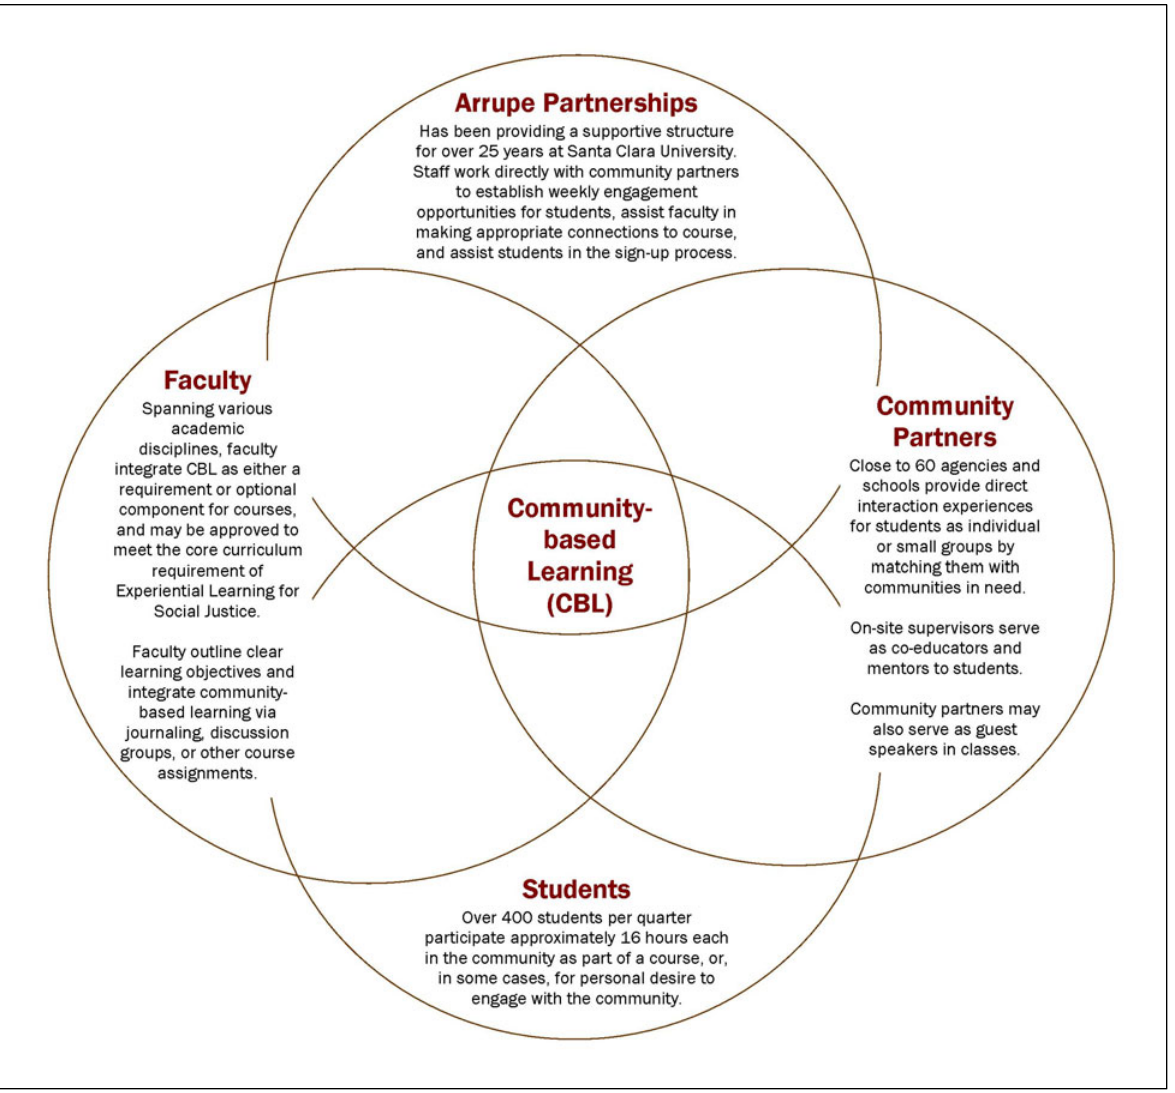
Figure 1. Community-based Learning: The